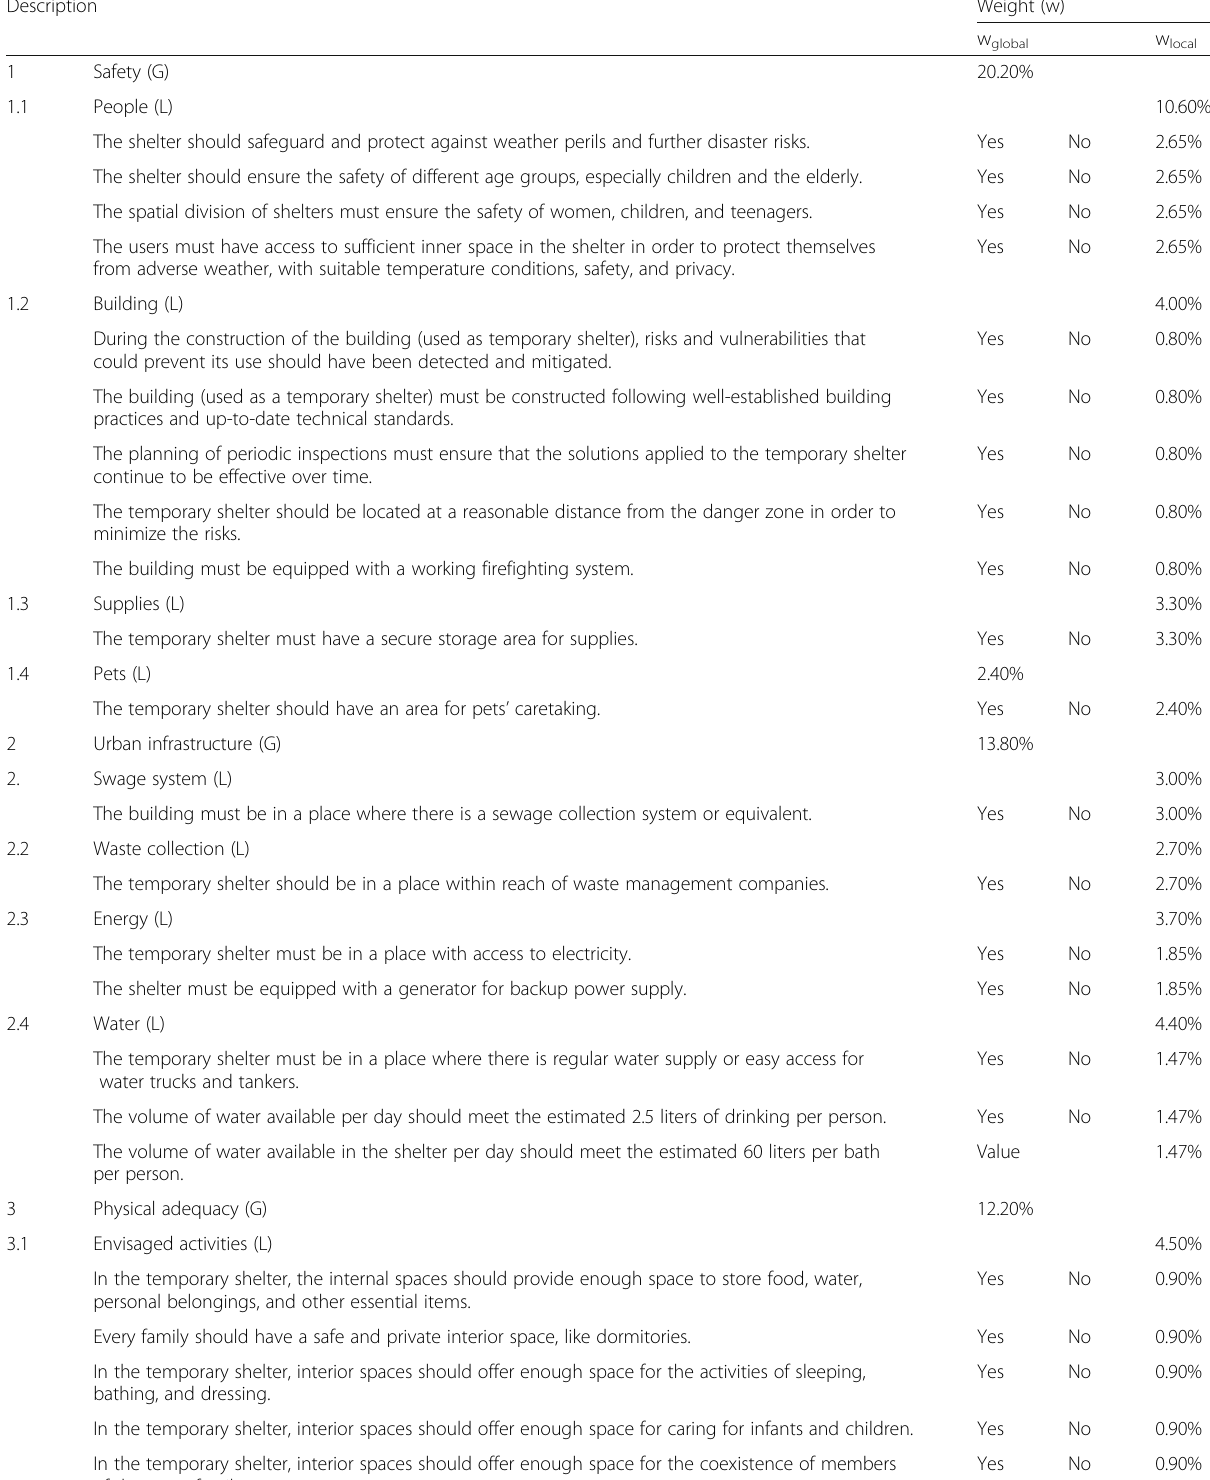
Table 2 Description of global criteria (G) and local criteria